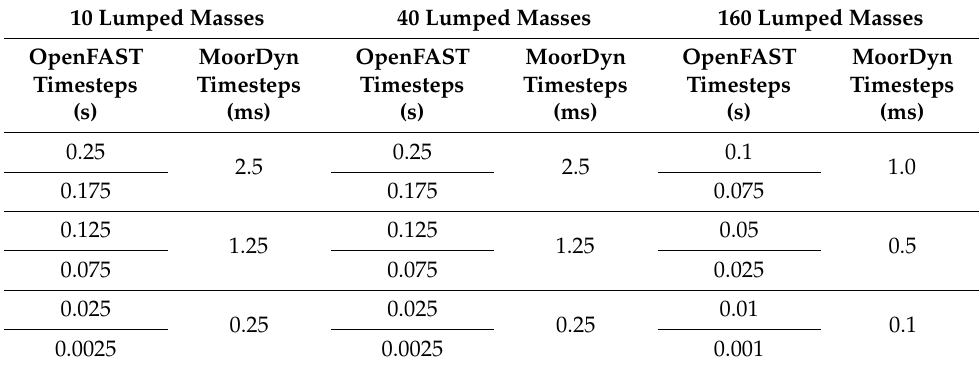
Table 8. OpenFAST and MoorDyn Convergence